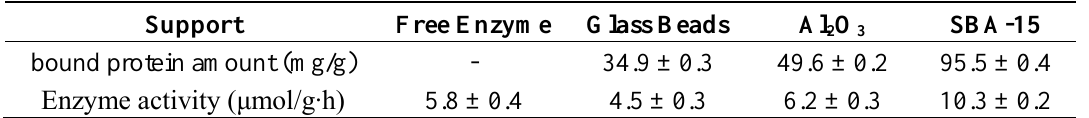
Table 1. Protein amount and enzymatic activity of free Trametes villosa laccase (TVL) and TVL immobilized on different